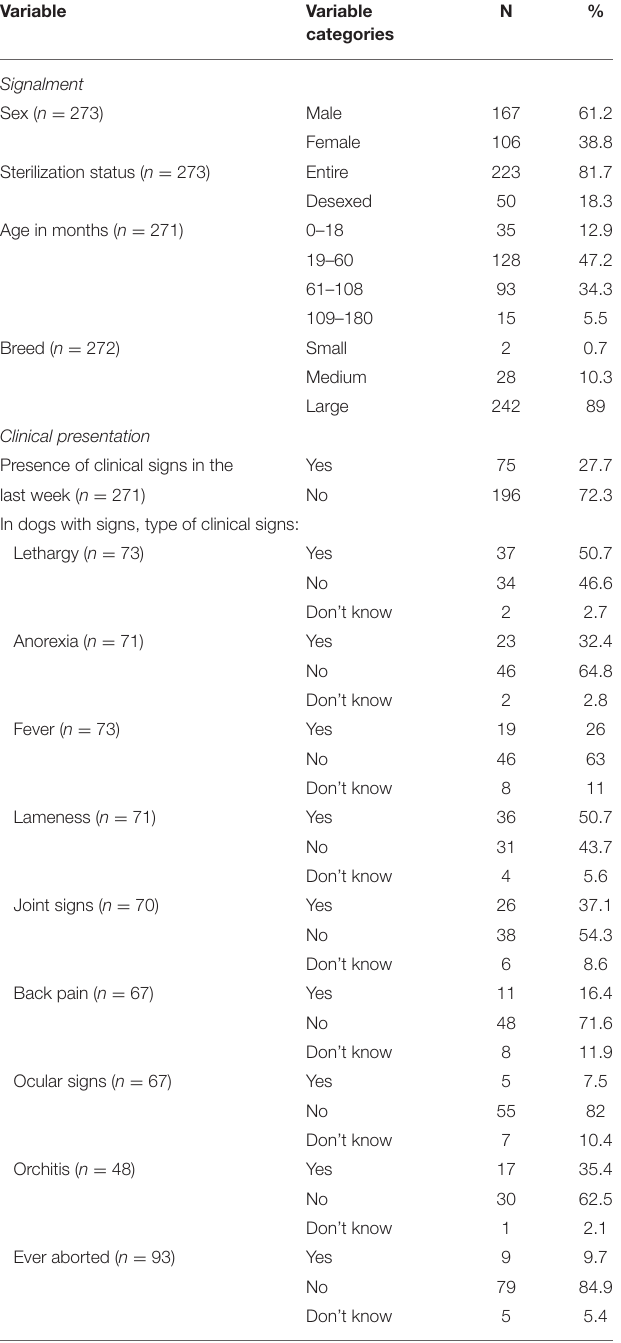
TABLE 1 | Signalment and clinical presentation of dogs at-risk of Brucella suis in eastern Australia, 2016 to 2019. Variable